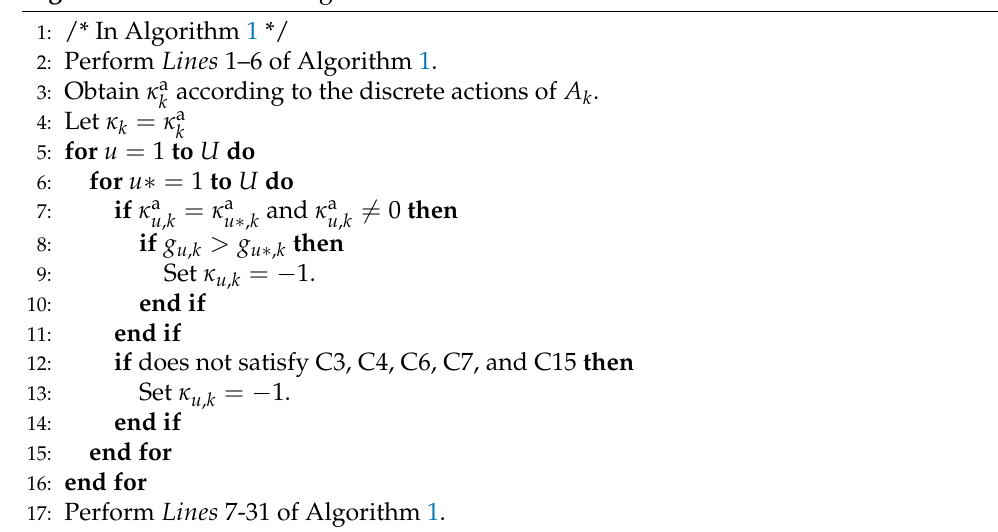
Algorithm 5 MAHPPPO